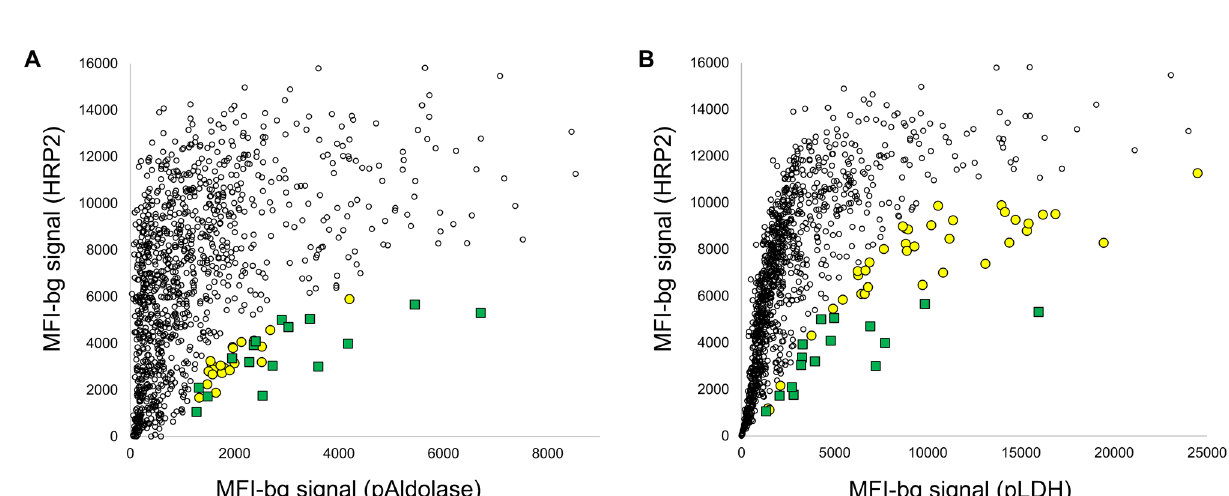
Table 2. Selection of samples for further genetic analysis by study site.